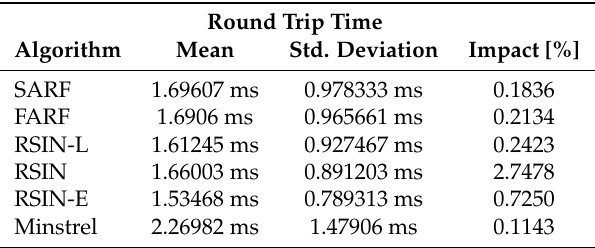
Table 5. Statistics of the Round Trip Time and Impact of the RA techniques Round Trip